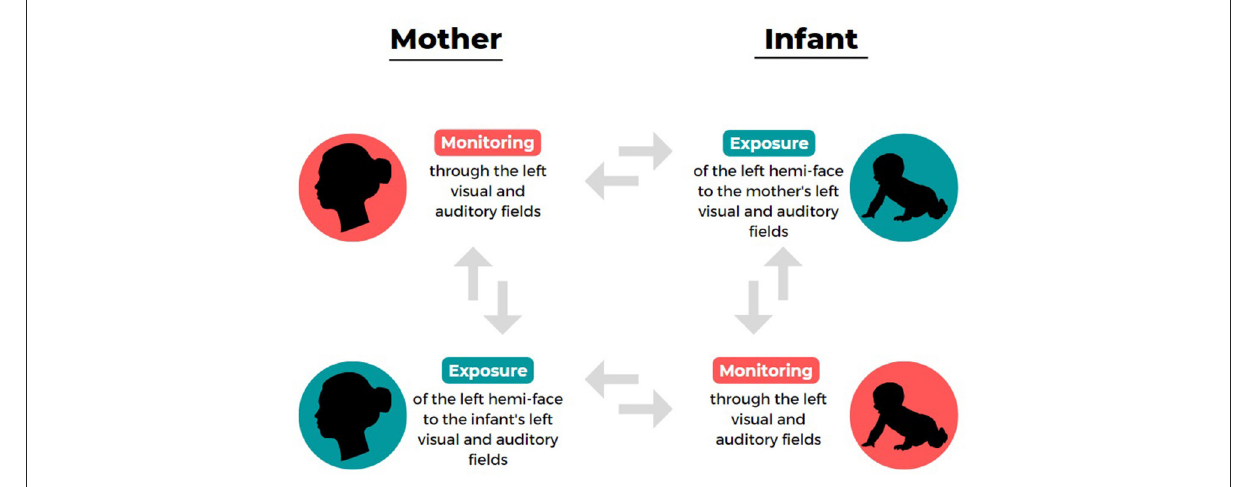
FIGURE1 The double exchange system of left-cradling bias (LCB) “monitoring and exposure” functions from the perspective of mother and